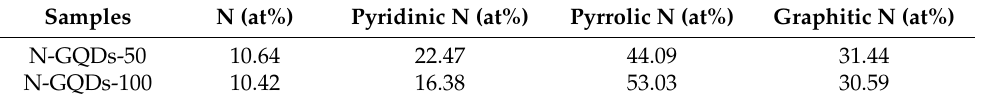
Figure 7. ( a ) Recycle stability of the photocatalytic decomposition of MO by N-GQDs/TiO 2 -50. ( b ) Repetitive photocatalytic decomposition of MO for TiO 2 and N-GQDs/TiO 2 -50 photocatalysts.